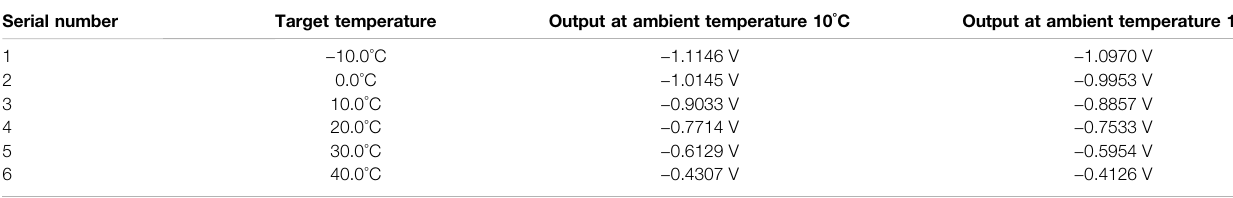
TABLE 1 | Calibration experimental data of infrared temperature measurement system.